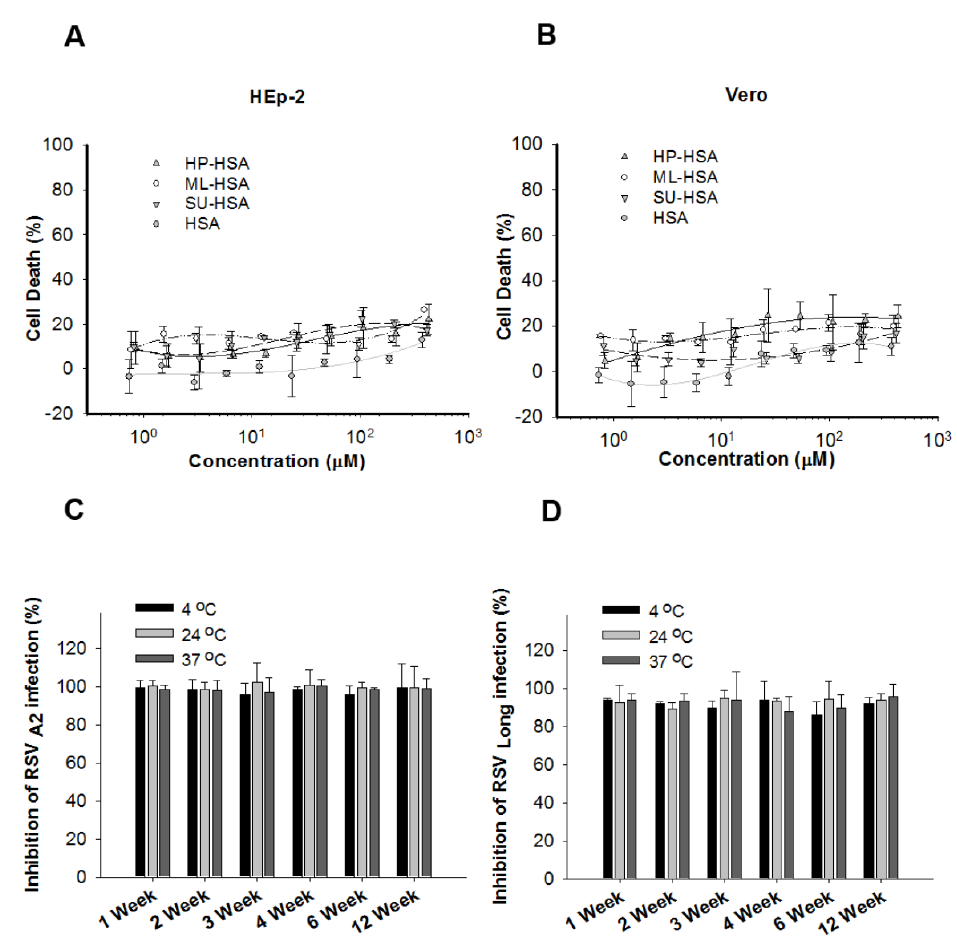
Figure 2. Cytotoxicity of different anhydride-modified HSA and the stability of ML-HSA. Cytotoxicity of HSA modified with HP, ML, and SU, respectively, to HEp-2 cells ( A ) and Vero cells ( B ) was determined by CCK8 kit. ML-HSA was stored at 4, 24 and 37 °C, respectively, for one to twelve weeks, followed by assessment of its antiviral activities against infection by RSV A2 strain ( C ) and Long Strain ( D ), respectively, were detected at the indicated time. Each sample was tested in triplicate, and the experiment was repeated twice. The data from one representative experiment were presented in mean ±